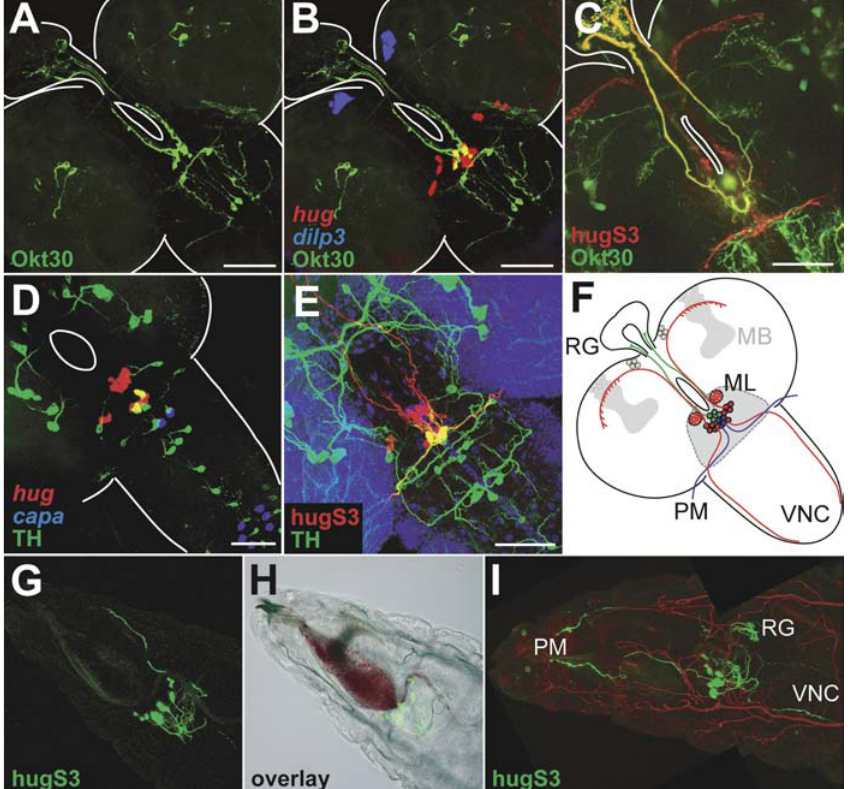
Figure 4. Subpopulations of hug Neurons Innervate Distinct Targets (A and B) Enhancer trap line Okt30 (shown in green) labels SOG neurons projecting to ring gland. Okt30 expression pattern colocalizes with hug expression (shown in red in [B]). There are four double positive cells in (B). dilp3 staining (blue) serves as morphological landmark. (C) Direct detection and false colorization of GFP expressed in Okt30 positive cells (green) and YFP expressed under hug promoter (red) reveals only the axons to ring gland as double positive. (D) TH promoter construct labels dopaminergic CNS neurons (shown in green). Four TH-positive SOG neurons also express hug (shown in red). capa staining (blue) serves as morphological landmark. (E) Combination of projection patterns of TH positive cells (green) with hug cells (red) reveals the axons innervating the pharyngeal muscles as the only double positive ones. (F) Schematic summary of (A–E) showing distinct subpopulations of hug neurons projecting to the ring gland only (green), pharynx only (blue), and the remaining targets (red). (G–I) Projection pattern of hug is unaffected in klu mutants. Direct detection and false coloring of hug promoter-YFP (shown in green) in the klu background reveals the pharyngeal muscles (PM), the ring gland (RG), and the VNC as being targeted in feeding mutants. Trachea are false-colored